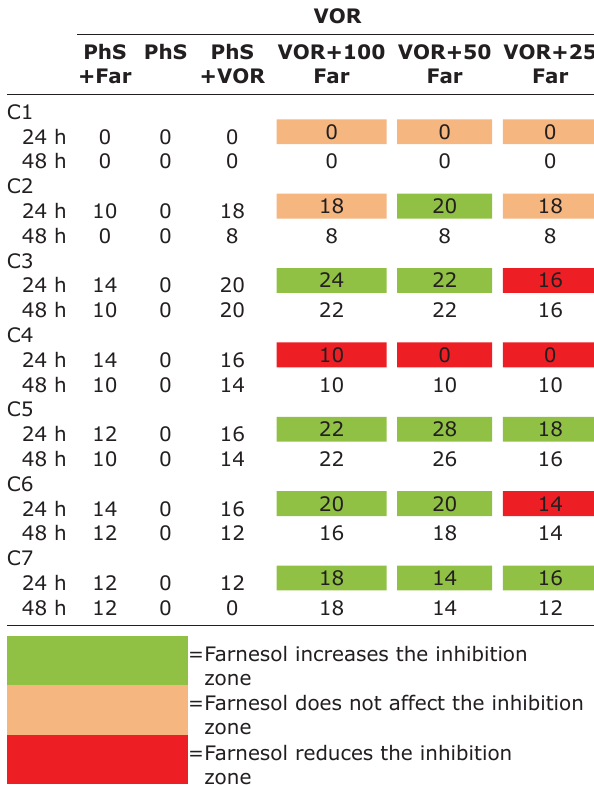
Table-5: Voriconazole sensitivity determination of 7 Candida albicans strains and the effect of farnesol three concentrations on these results.